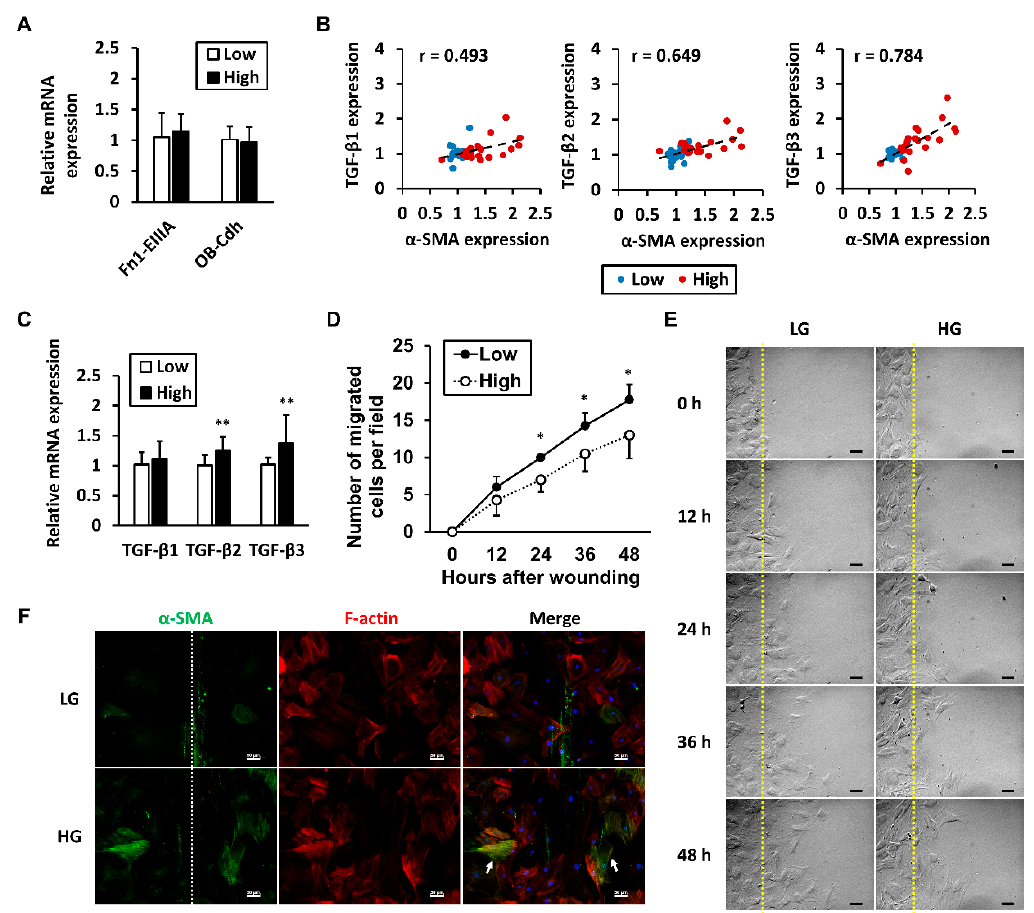
Figure 3. High glucose-induced increases in α -SMA expression do not indicate myofibroblastic differentiation. Tenocytes were cultured in high-glucose (HG) or low-glucose (LG) conditions for 1 week. ( A ) mRNA expression levels of the myofibroblast markers Fn1-EIIIA and OB-cdh were measured. Data are presented as the mean ± SD ( n = 6); ( B ) Pearson’s correlation coefficients between mRNA levels of TGF- β s and α -SMA were calculated. Cell samples of both low- and high-glucose groups from four independent experiments (total n = 42) were included; ( C ) The mean ± SD of TGF- β mRNA levels in pooled samples are shown by group; ( D ) Cell migration rate is presented as the number of tenocytes that migrated into the wound at each time point ( n = 3). Images of migrating cells are shown in ( E ), where the yellow dotted lines represent the outline of wounds; ( F ) F-actin and α -SMA (smooth muscle actin) were fluorescently labeled after wound closure, where white dotted lines represent the midline of wounds. No α -SMA-positive tenocytes migrated to the midline (arrows). Statistical significance is shown as * p < 0.05 or ** p < 0.01 compared to the low-glucose control group. Scale bar = 50 μ m.